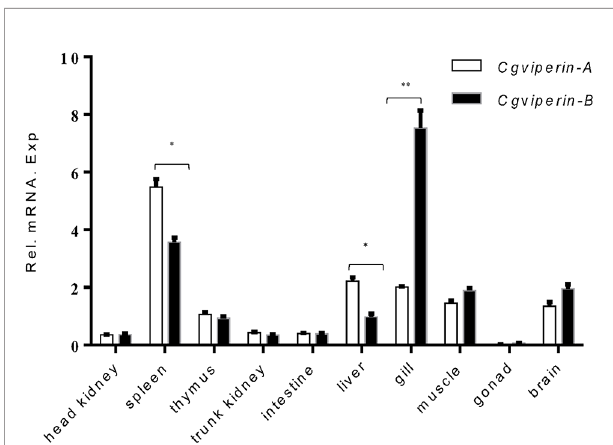
FIGURE 2 | qPCR analysis of Cgviperin-A and Cgviperin-B expression in adult tissue from healthy gibel carp clone F. Eukaryotic translation elongation factor 1 alpha 1 , like 1(eef1a1l1) was used as control. Each bar represents mean ± standard deviation (SD) (n = 3). * P < 0.05, ** P <